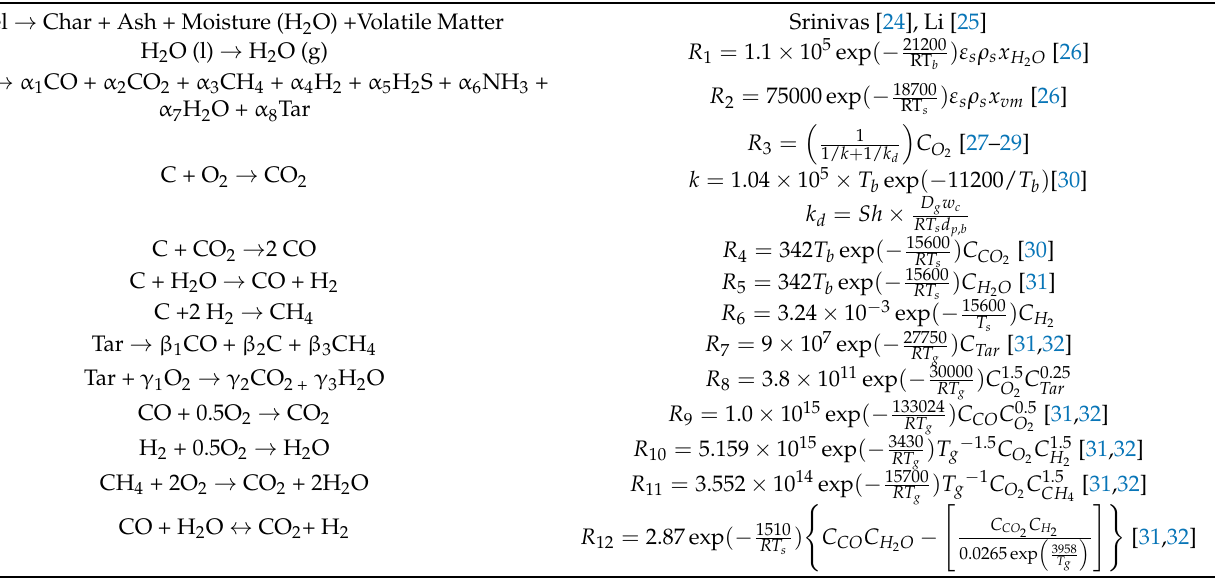
Table 2. Main reactions in the